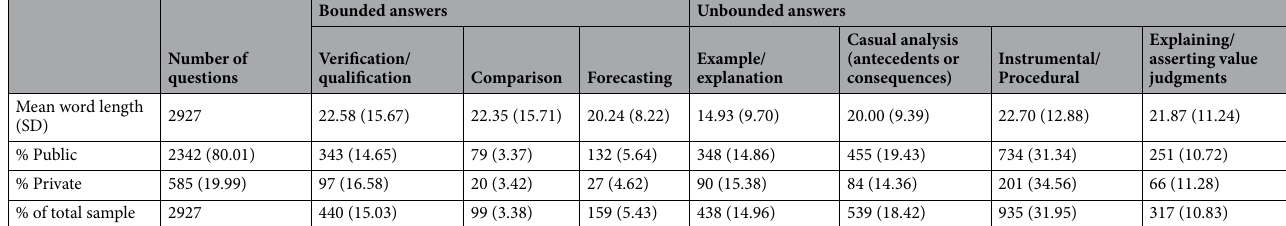
Table 5. Summary: frequencies (%) and mean word length (SD) of questions according to superordinate and subordinate categories of the Taxonomy of Policy Questions. This table sets out the Taxonomy of Policy Questions. For each question-style, it shows: its mean word length (SD), the percentage of questions of this style which came from public policymakers, the percentage of questions of this style which came from private policymakers, and the percentage of questions of this style within the total